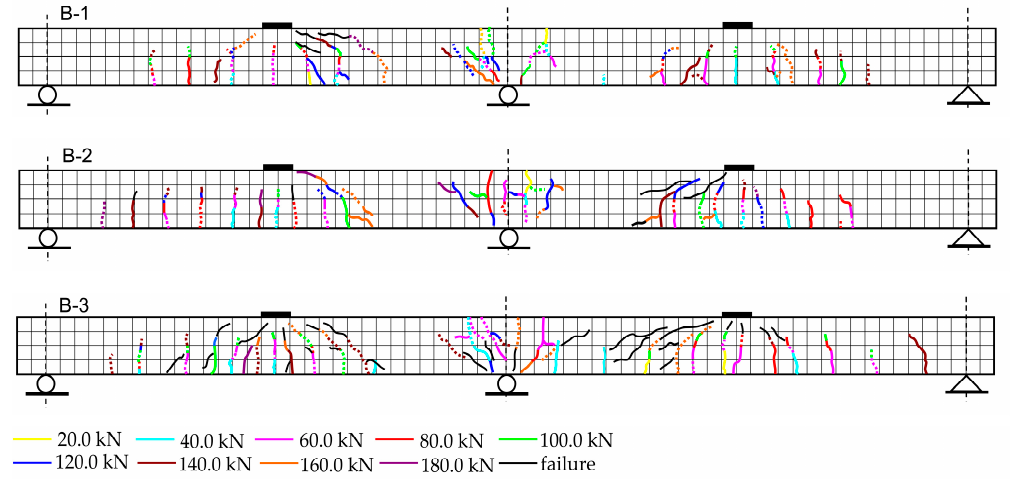
Figure 6. Map of cracks of B − 1, B − 2 and B − 3 beams.